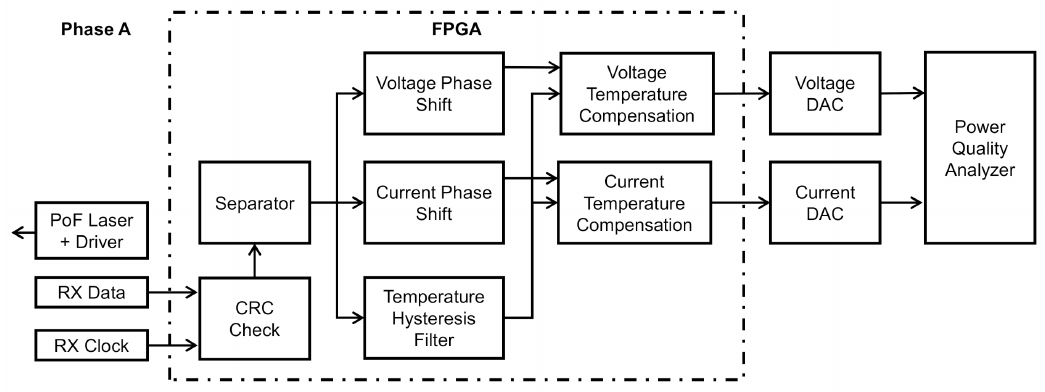
Figure 5. Processing unit block